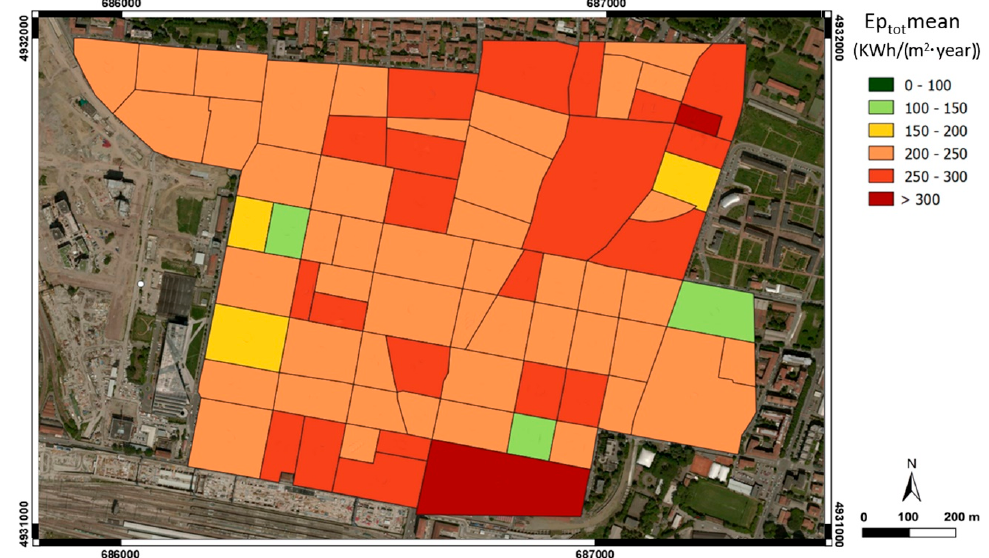
Figure 5. Ep tot mean value map corresponding to the validation area (Bolognina) at block scale. Bing aerial imagery is used as the base map.